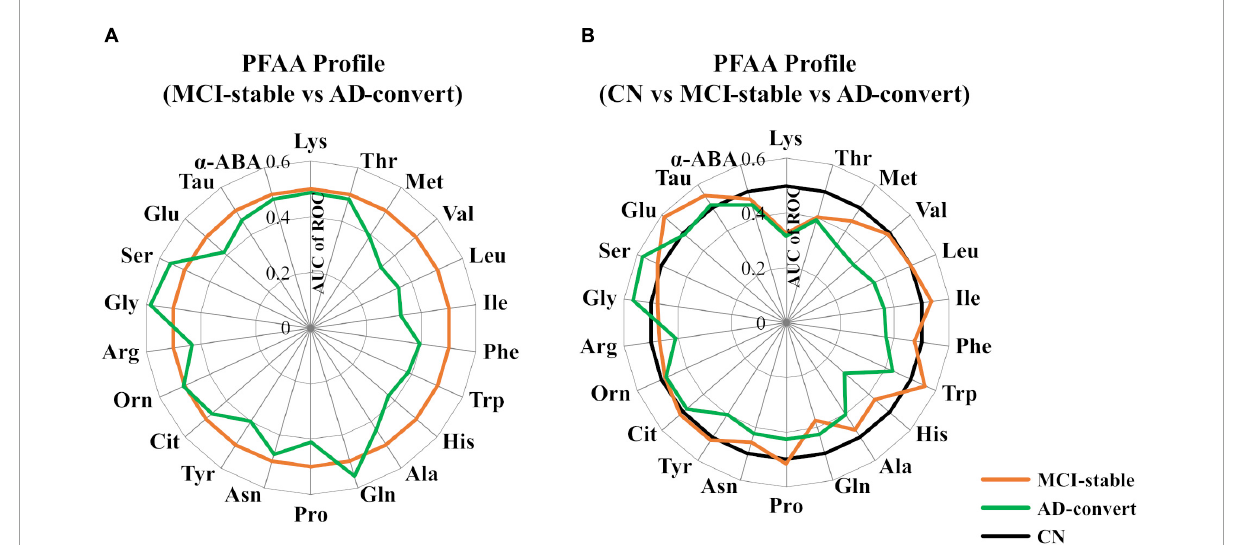
FIGURE2 Comparison of plasma free amino acid (PFAA) concentrations among mild cognitive impairment (MCI)-stable, Alzheimer’s disease (AD)-convert, and cognitively normal (CN) individuals. Differences in PFAA concentrations between groups are described by the receiver operating characteristic (ROC) of an area under the curve (AUC). (A) The MCI-stable group was set as the control. (B) The CN group was set as the control. In the CN group, taurine data were partially missing ( N = 48 were missing).